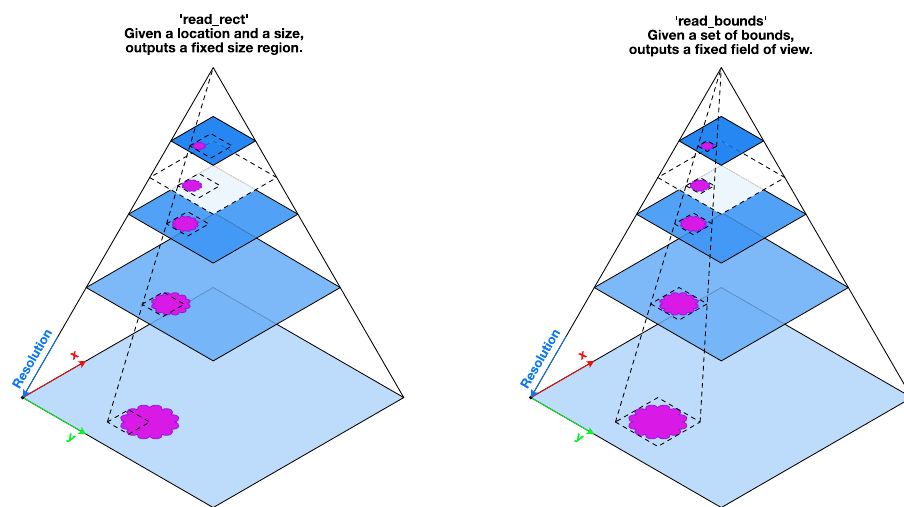
Fig. 1 Illustration of two modes of random-access read from a multi-resolution (pyramidal) WSI. Different resolutions, stored in the WSI, are shown as blue planes stacked on top of each other. A lower resolution is a stored down-sampled copy of the highest resolution (baseline). Here both read modes, read_rect and read_bounds, illustrate reading a region of interest containing some tissue (magenta shape) at a desired resolution. Reading of a region which is not at a pre-computed and stored resolution within the WSI (transparent white plane with a dashed outline) results in a read via a down-sample interpolation from a level with higher